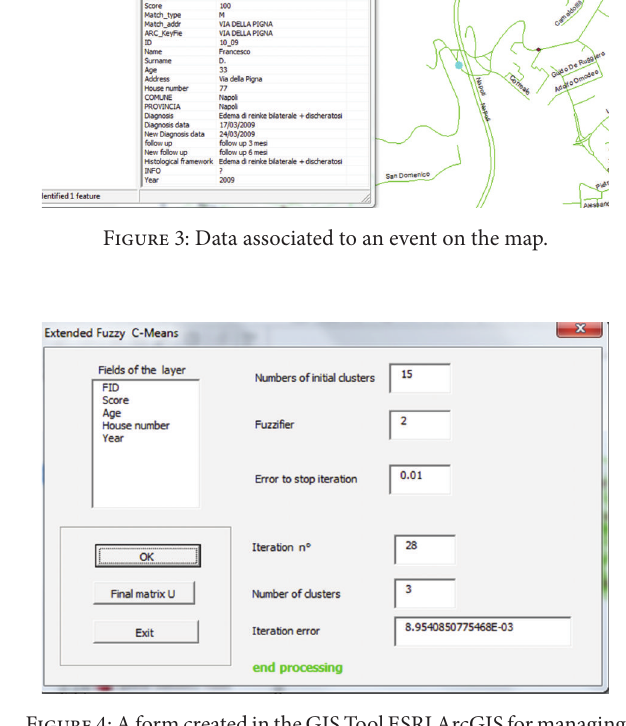
Figure4:AformcreatedintheGISToolESRIArcGISformanaging the EFCM